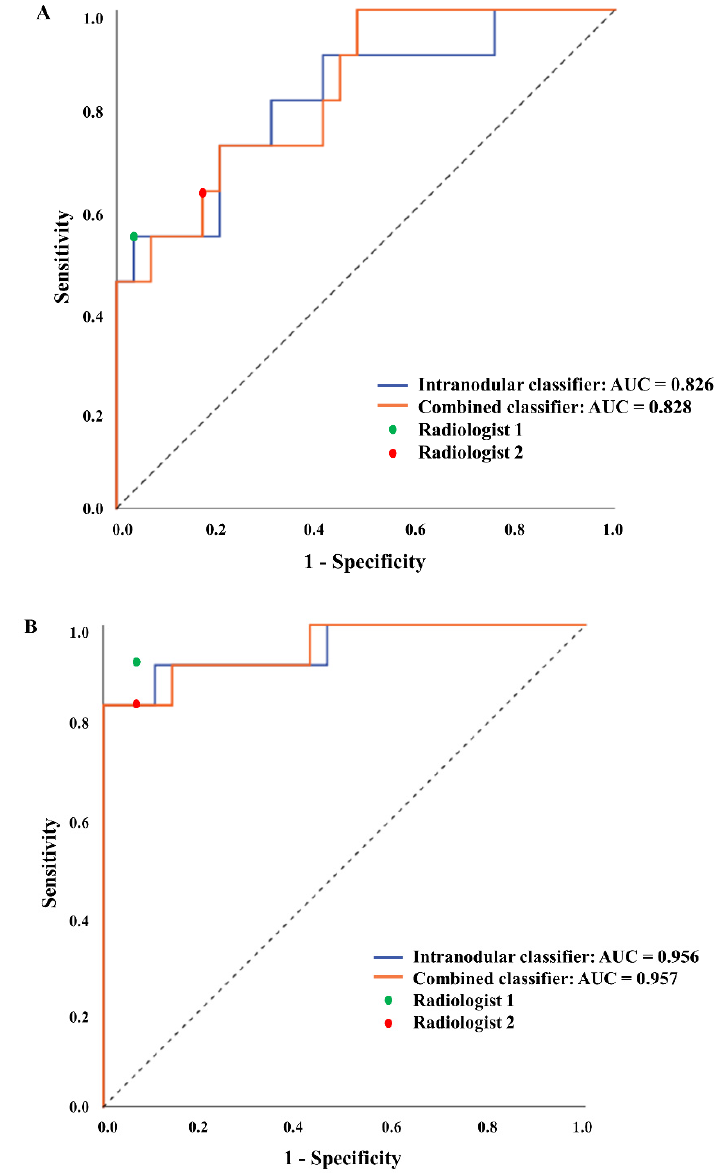
Figure 3. Graphs show the area under the receiver operating characteristic curve (AUC) of intranodular and combined classifiers in the internal ( A ) and external ( B ) testing datasets. The sensitivity and specificity of two radiologists are plotted as green and red dots, respectively.